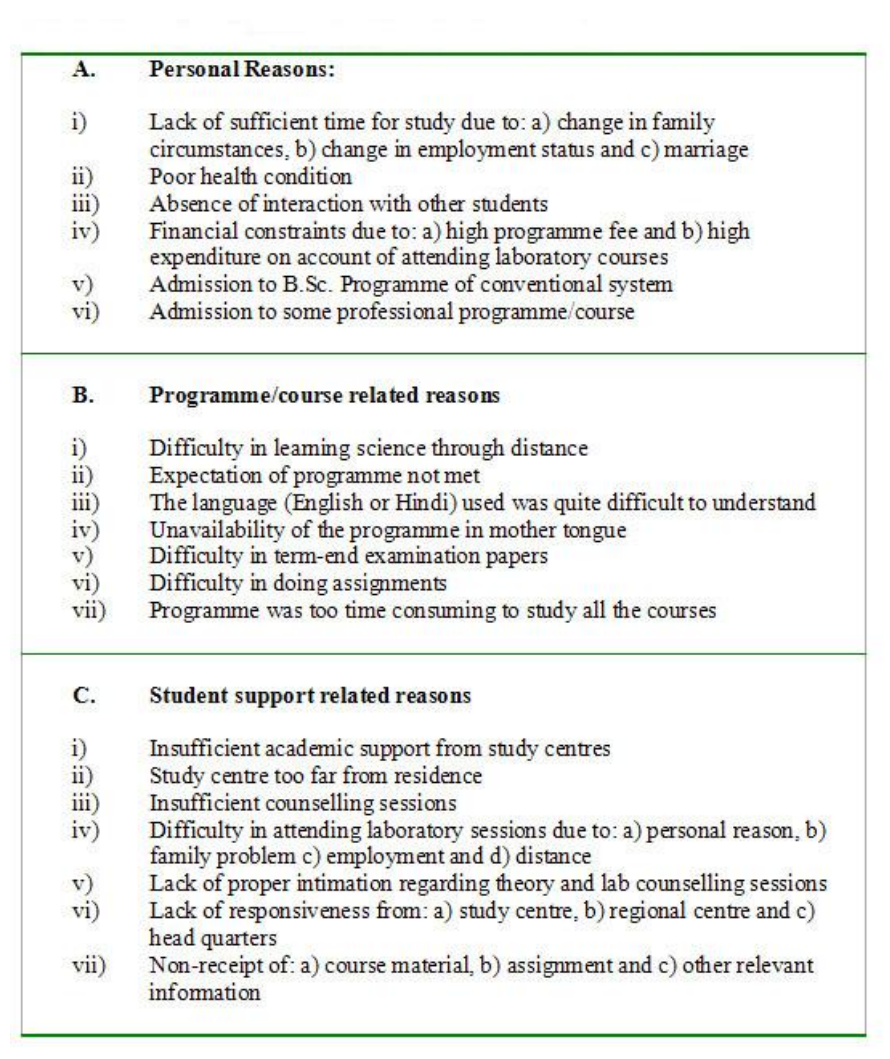
Figure 1. Categories of reasons for discontinuing BSc